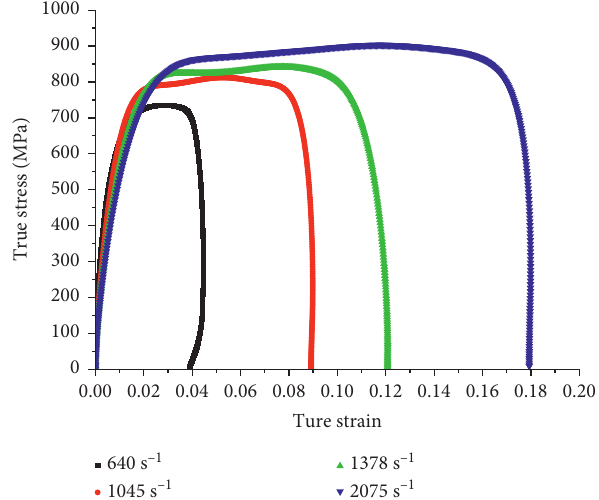
Figure 9: Real stress-strain relationship of 15-5PH stainless steel at different strain rates.